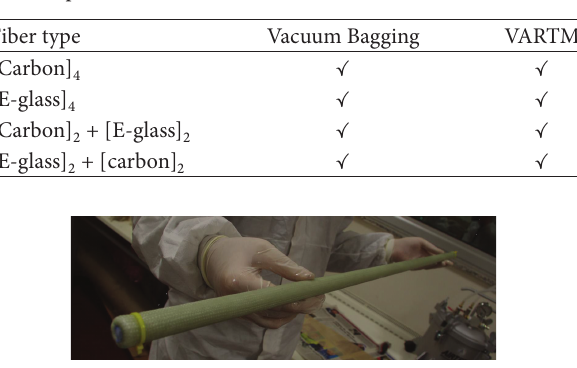
Figure 1: A Vacuum Bagging specimen before the bagging